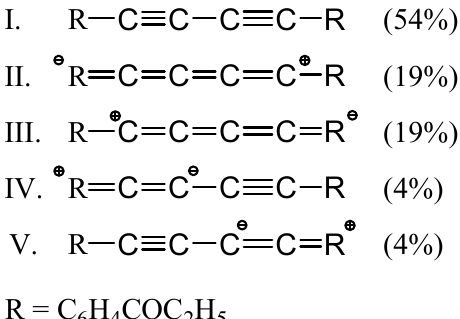
Figure 5. Percentage contributions of the Lewis structures representing the bonding in the